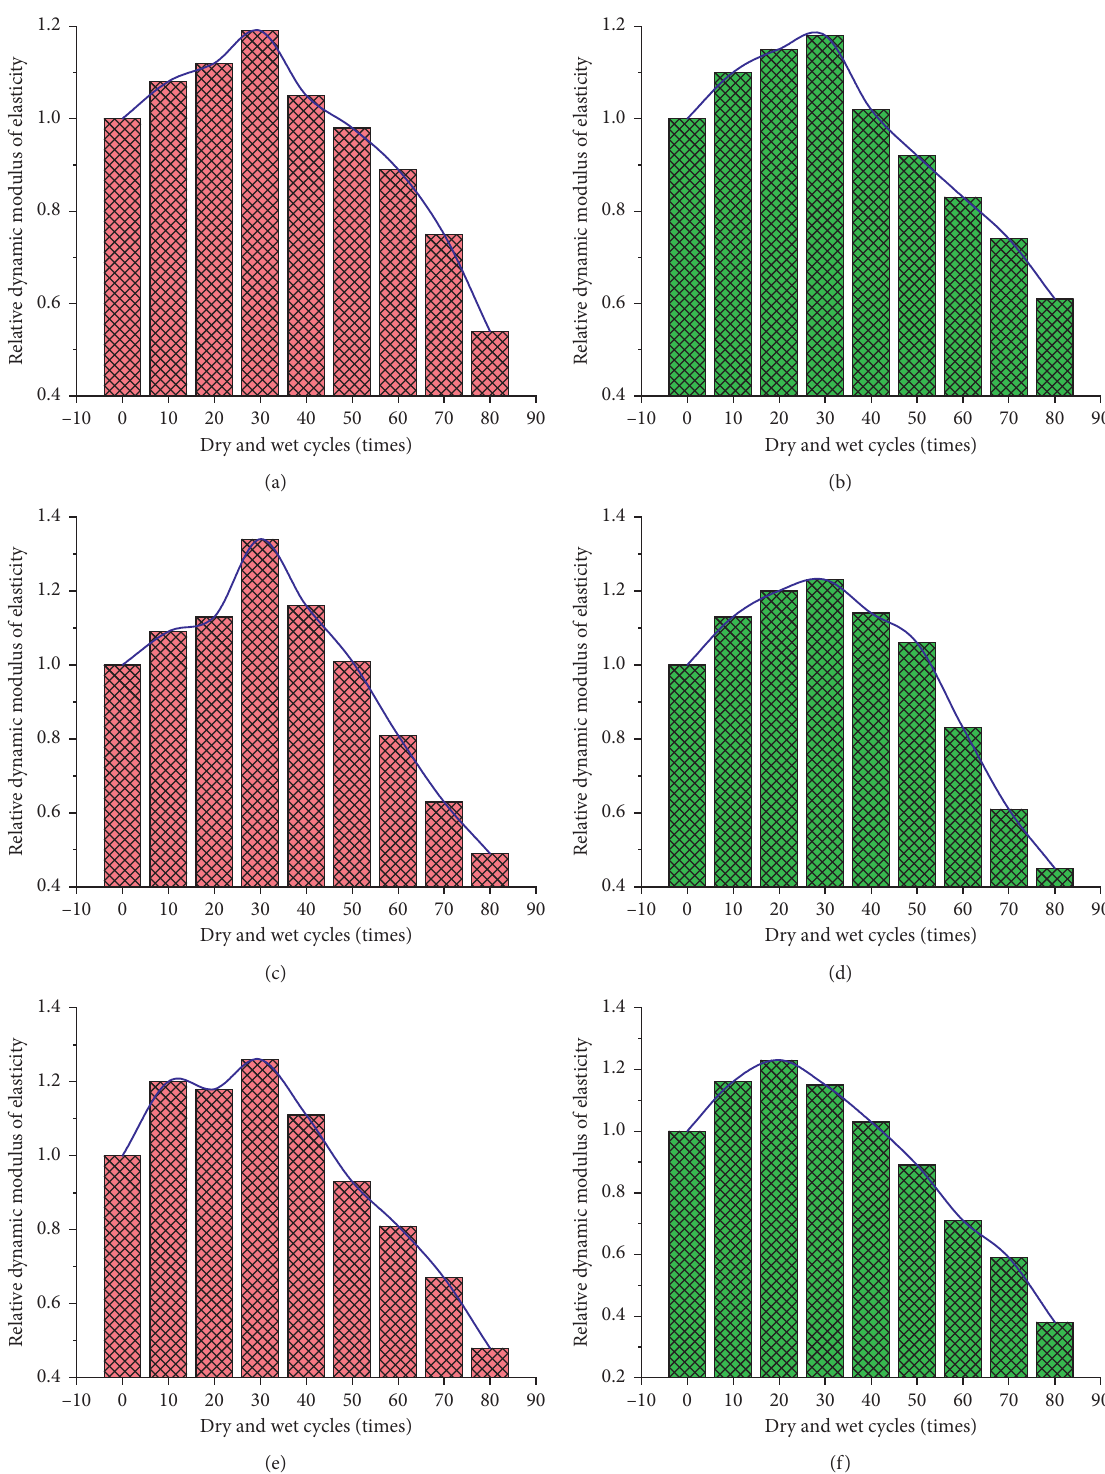
Figure 5: Relative dynamic elastic modulus of recycled concrete. (a) RCA0%–RFA0%. (b) RCA0%–RFA15%. (c) RCA30%–RFA0%. (d) RCA30%–RFA15%. (e) RCA50%–RFA0%. (f)